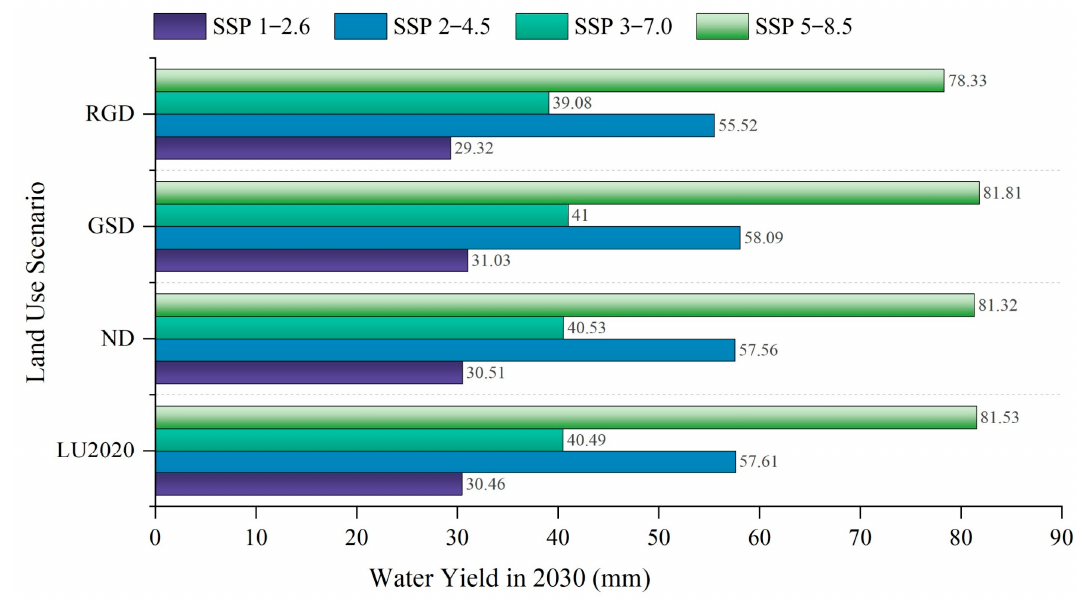
Figure 10. Water yield in 2030 in different land use policy and climate change scenarios.